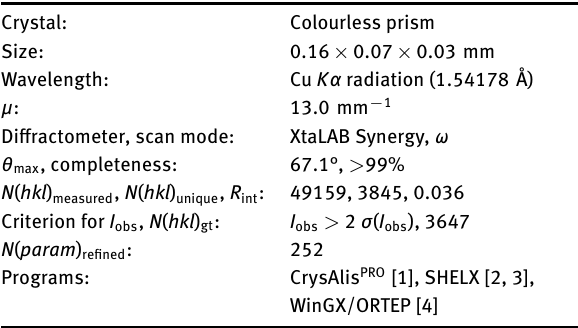
Table 1 contains crystallographic data and Table 2 contains the list of the atoms including atomic coordinates and dis- placement parameters.